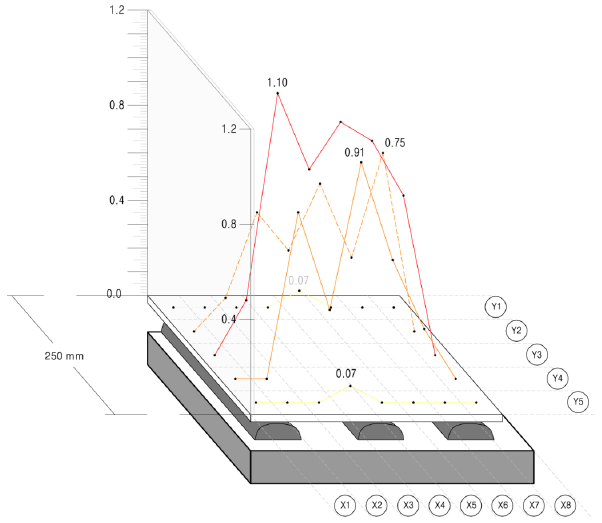
Figure 14. AR 60 ± 2% specimen adhesion strength per piece coordinate (average).